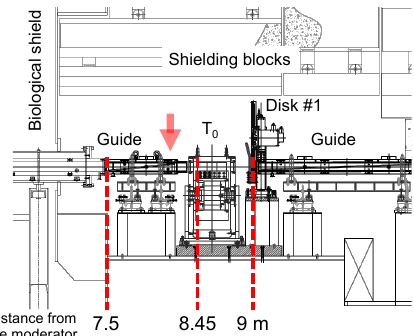
Figure 4. Cutaway view of 4SEASONS after the biological shield. “Guide,” “T 0 ,” and “Disk #1” denote parts of the neutron guide, the T 0 chopper, and the first disk chopper, respectively. The arrow indicates the candidate position of the pulse-removal